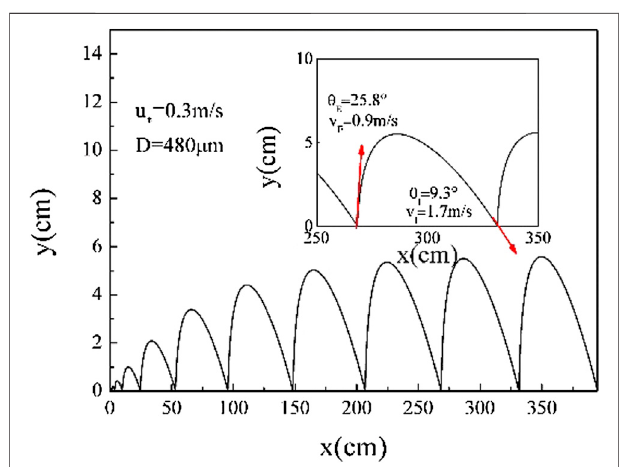
FIGURE 2 | Flow chart of the calculation steps.